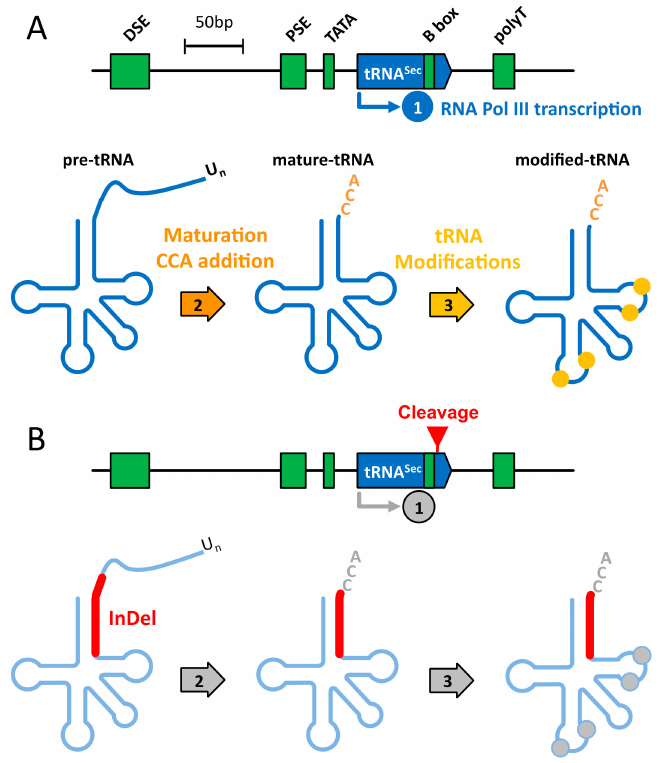
Figure 2. Design of a clustered regularly interspaced short palindromic repeats (CRISPR) strategy that disrupts Sec-tRNA [Ser]Sec expression and function. ( A ) Schematic representation of the transcription by RNA PolIII (1), maturation (2), and modification (3) stages of wild type tRNA [Ser]Sec from the TRNAU1 gene. ( B ) Illustration of the various possible consequences of our CRISPR strategy. In response to the dsDNA break caused by Cas9-sgRNA in Table S1. Nucleotide insertion or deletion (Indel) can occur at the cutting site due to imperfect repair by NHEJ. This Indel can impact the tRNA [Ser]Sec expression at three levels: (1) The e ffi ciency of transcription by altering the B box and / or the termination site, (2) the removal of the 3’-trailer and the CCA-addition at the 3 (cid:48) -end of the tRNA by altering the recognition of the tRNA by the respective enzymes (tRNA endonuclease and tRNA nucleotidyltransferase), and (3) the modifications of the tRNA. In any case, the action of Cas9-sgRNA at this site leads to impaired and / or reduced levels of tRNA [Ser]Sec . The tRNA sequence and the important regions for the transcription are represented in blue and green, respectively. DSE, distal sequence element; PSE, proximal sequence element; TATA, TATA box; polyT, transcription stop